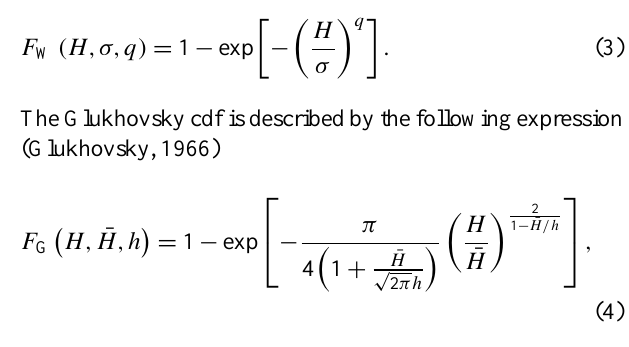
Fig. 4. Averaged distribution of wave heights within the wave wake; red dashed line corresponds